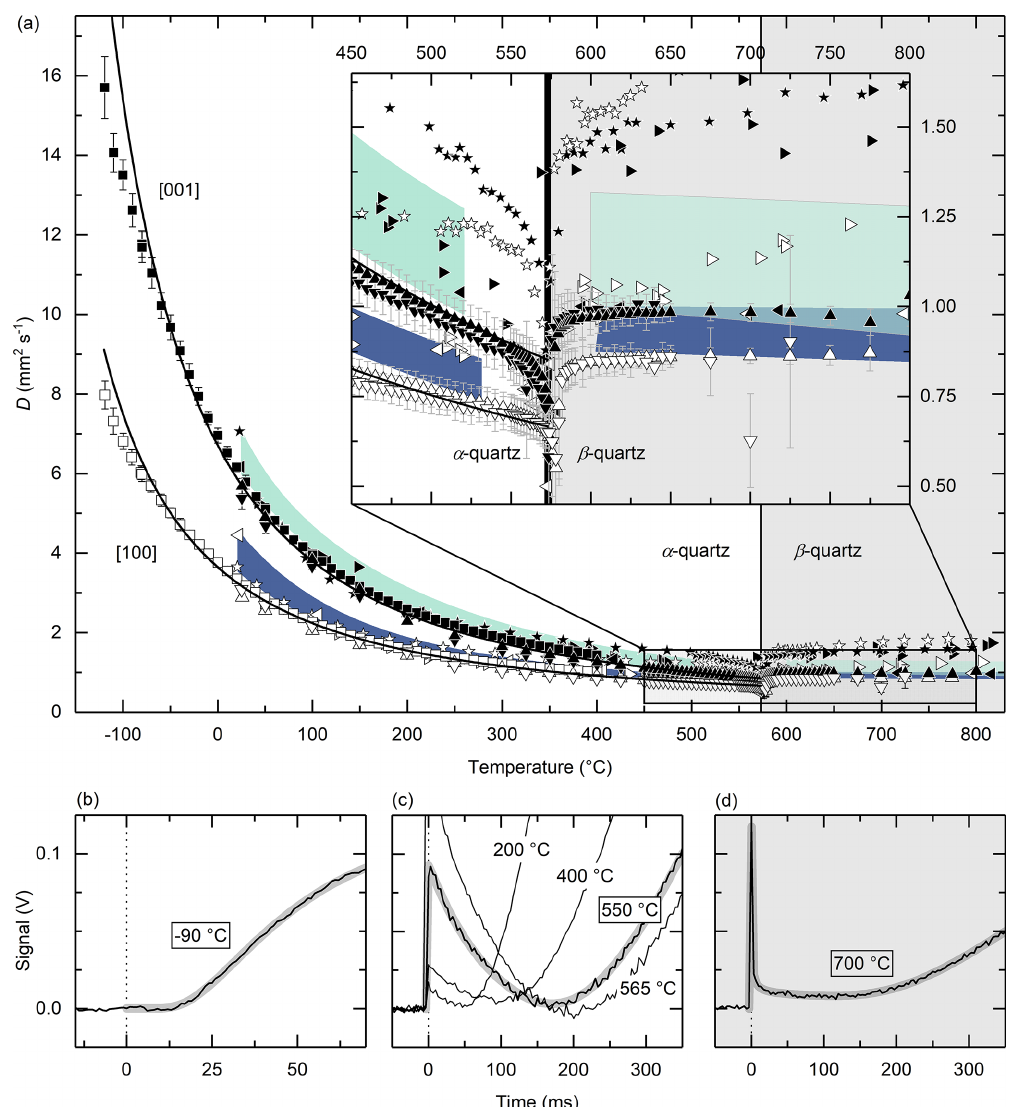
Figure 2. (a) Measured lattice (phononic) thermal diffusivity D of synthetic quartz single crystals between − 120 and 800 ◦ C over the α – β phase transition at T α,β = 573 ◦ C. Low-temperature data (squares) are shown for the [001] (black filling) and [100] directions (white filling). High-temperature data are shown from 25 to 800 ◦ C for specimens HT1 (upwards triangles) and HT2 (downwards triangles). D(T ) data fits (black line) after Eq. (9) for T ≤ 550 ◦ C in the [001] and [100] directions are shown up to the phase transition at 573 ◦ C. Literature data are shown as rightwards triangles – Kanamori et al. (1968), stars – Höfer and Schilling (2002), and leftwards triangles – Branlund and Hofmeister (2007) (“SynQ” specimen). Green and blue areas correspond to the variations of measured D values given by Branlund and Hofmeister (2007) for the [001] and [100] directions. Front sections of specimen HT1 [ 001 ] raw data signal–time curves (black lines) and data fits (thick grey) are shown for temperatures (b) T = − 90 ◦ C, (c) 550 ◦ C (with additional raw data shown for 200, 400 and 565 ◦ C) and (d) 700 ◦ C. Fits of the latter two include a fast radiative heat transfer portion according to Eq. (8) with T i ∝ τ i (c) and T i ∝ 1 / respectively. For details, see the